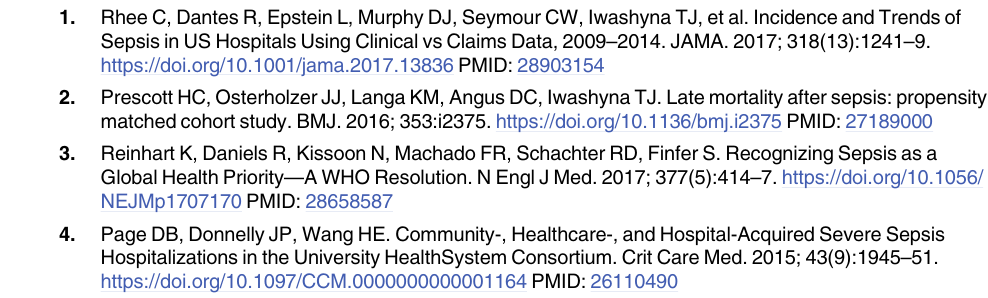
S1 Fig. Data collection process. Description Patient flow diagram showing the number of patients included and